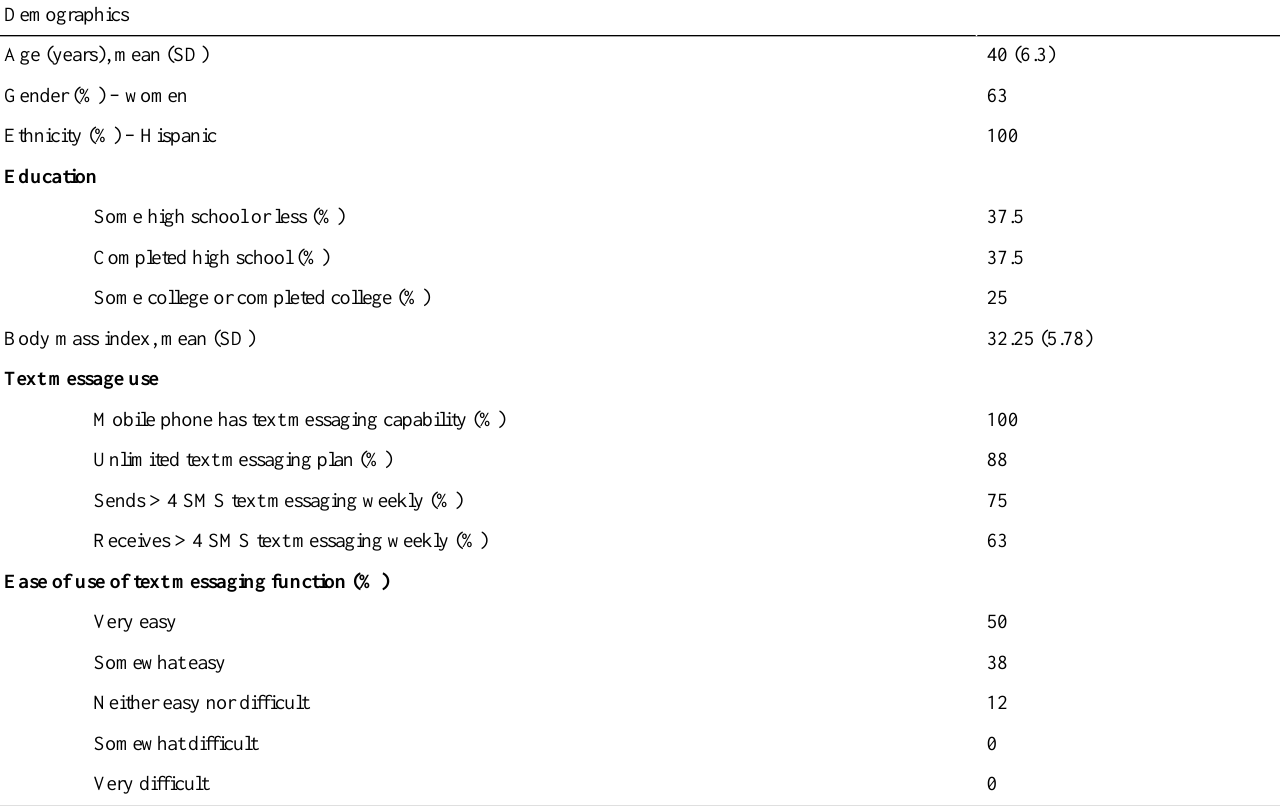
Table 1. Demographics and text message